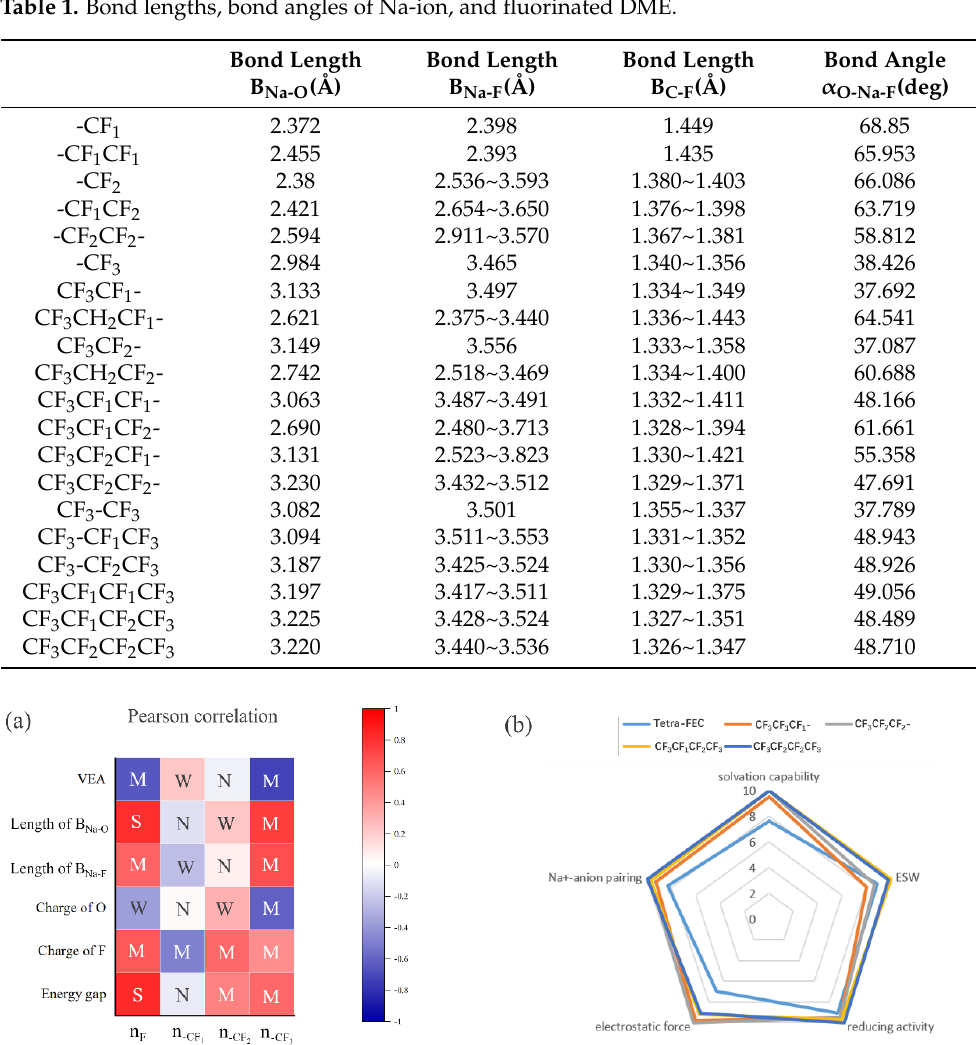
Table 1. Bond lengths, bond angles of Na-ion, and fluorinated DME.